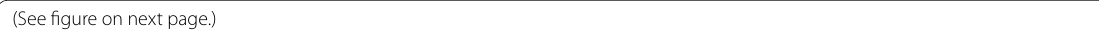
figure on next Fig. 1 A Representation of progression of the weight of the animals included in the study during the 9‑month growth period (monthly measurement) (n 10–21/experimental groups). B ITT results were extrapolated into an area under the curve value which was used for the = statistical comparison. Results were represented as bar graphs or violin plots. Differences between groups were analyzed using ANOVA and Tukey’s. Significance was represented as follows: *p < 0.05, **p < 0.01 and ***p < 0.001 (n 10–12/experimental group). C Graphical representation of the = individual values of the discrimination ratio of the animals in the NORT. Values were calculated by using the following formula: discrimination ratio (time spent exploring the new object time spent exploring the known object)/total exploration time. Any animals that showed lower than = − average activity or any divergent preference for one of the identical objects in the training had their results discarded from the analysis (n experimental